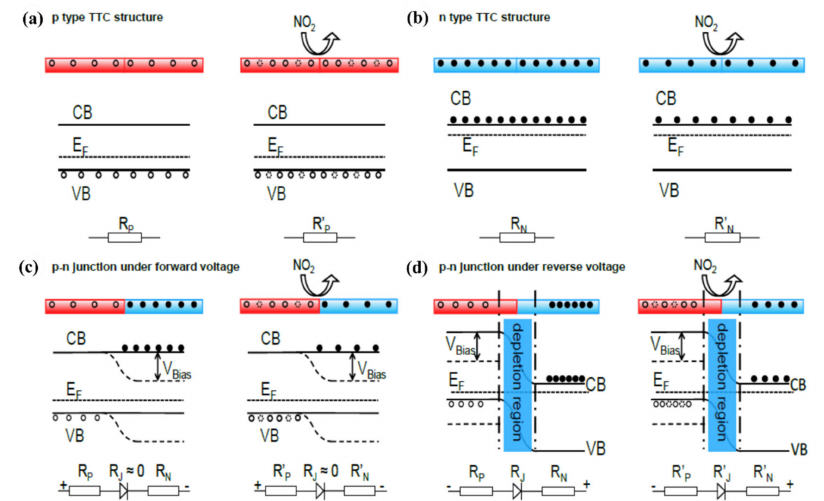
Figure 16. Schematics and energy band diagrams of different contact structures before and after being exposedtoNO 2 for( a )p-typeSiNWscontactstructure,( b )n-typeSiNWscontactstructure,p-nhomojunction under forward voltage ( c ) and reverse voltage ( d ). Reproduced from [137], with permission from RSC Pub, 2020. ( • , electron; , (cid:35)